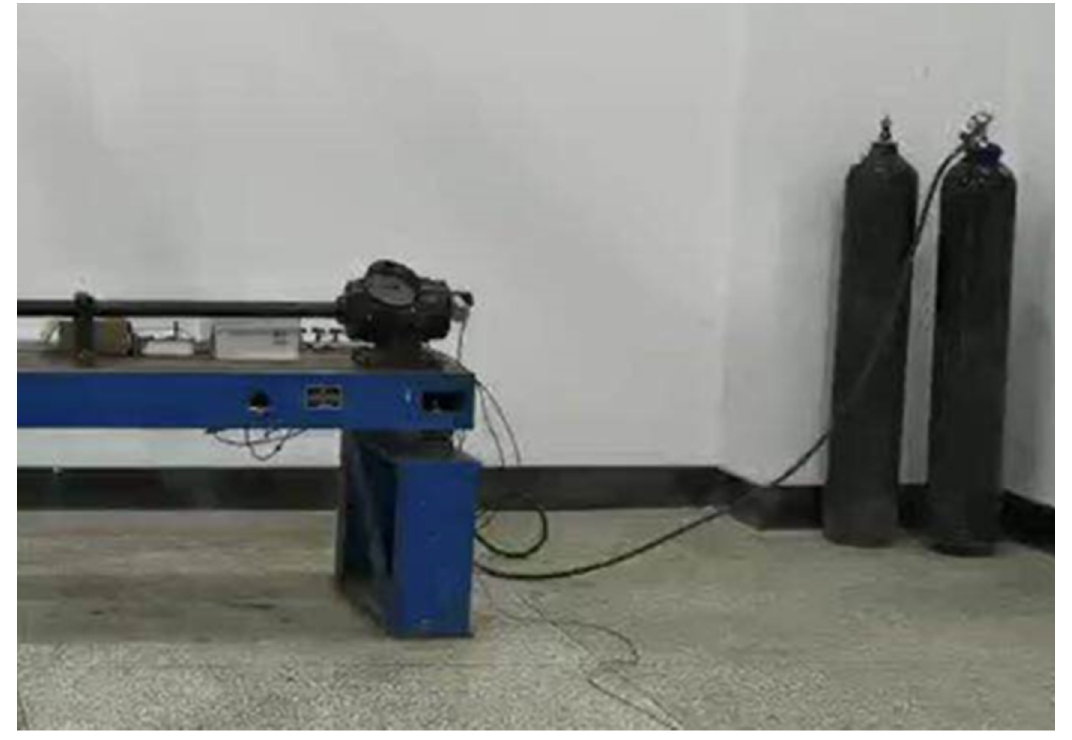
Figure 3. Shock experiment of the typical spacecraft structure.